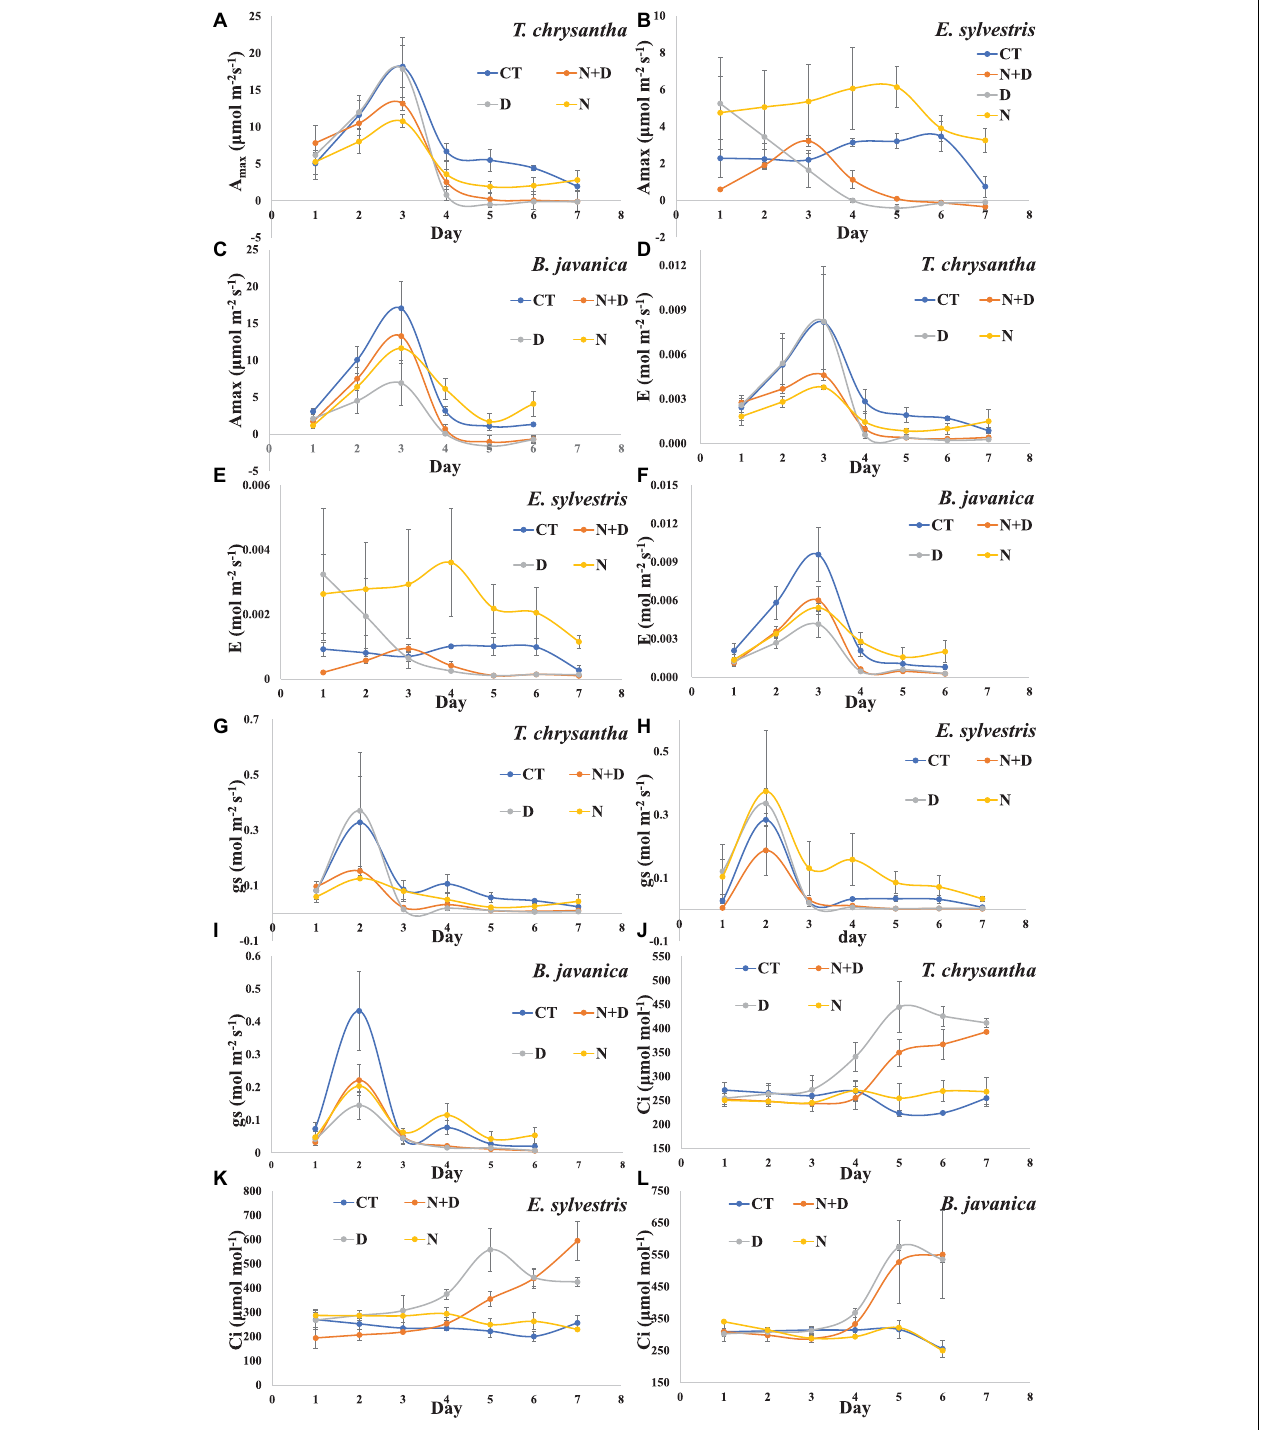
FIGURE 3 | Changes in light-saturated net photosynthetic rate (A max ) (A–C) , transpiration rate (E) (D–F) , stomatal conductance (g s ) (G–I) , intercellular CO 2 concertation